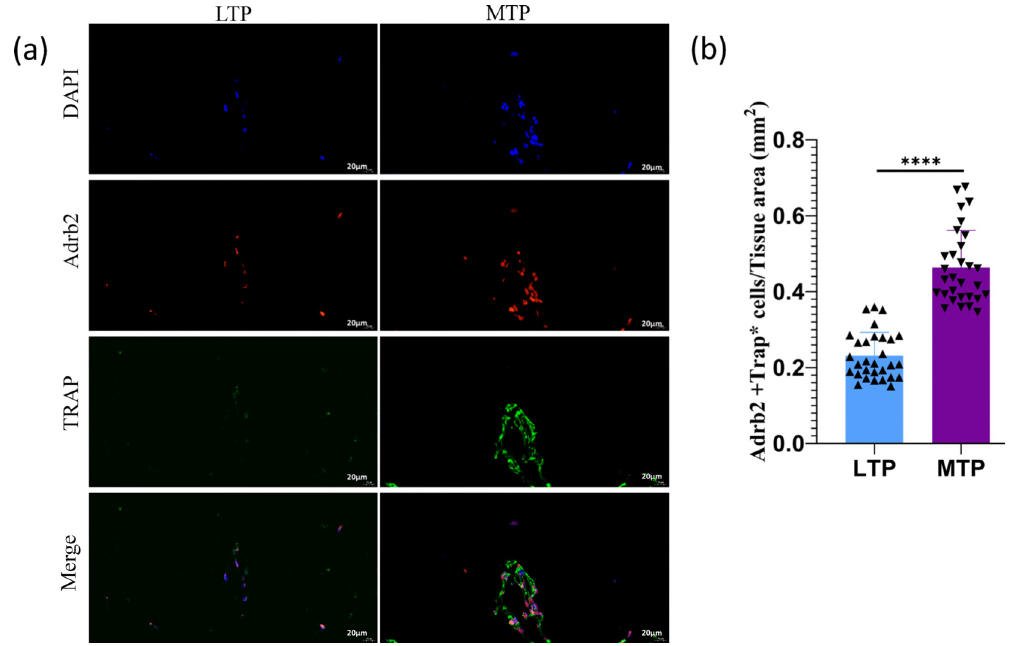
Figure 6: Immuno fl uorescence double - labeling staining analysis of Adrb2 and TRAP co - expression in subchondral bone of LTP and MTP. ( a ) Distribution of Adrb2 and TRAP in the subchondral bone of LTP and MTP. Double immuno fl uorescence of Adrb2 ( red ) /TRAP ( green ) labeled multinucleated cells. Nuclei were stained with DAPI ( blue ) . ( b ) Bar graphs show semiquantitative evaluation of Adrb2 and TRAP co -